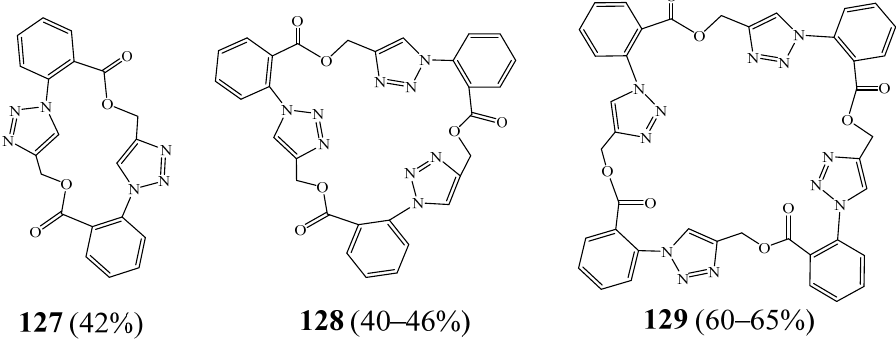
Figure 32. Macrocycles containing two, three, and four 1,2,3-triazole motifs 127 − 129. (Reprinted with permission from ref. [53]. Copyright 2012 © Georg Thieme Verlag KG).